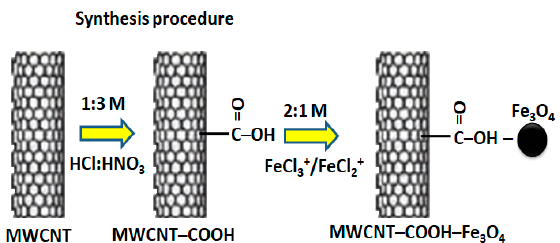
Figure 1. Synthesis procedure of multi-walled carbon nanotubes (MWCNTs) + Fe 3 O 4 hybrid nanoparticles.